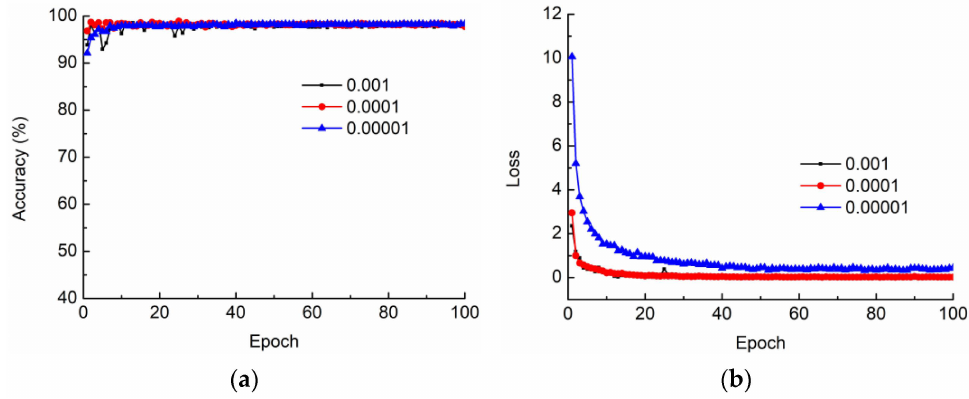
Figure 6. Validation results of different learning rates using SGD: ( a ) Accuracy; ( b ) loss value.